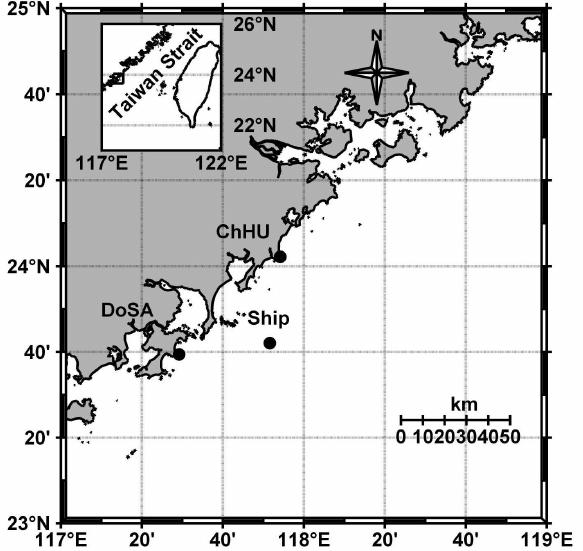
Figure 1. Location of the distributed HF radar network including three radar sites (black dots): the ChHU site, the DoSA site, and the ship site.